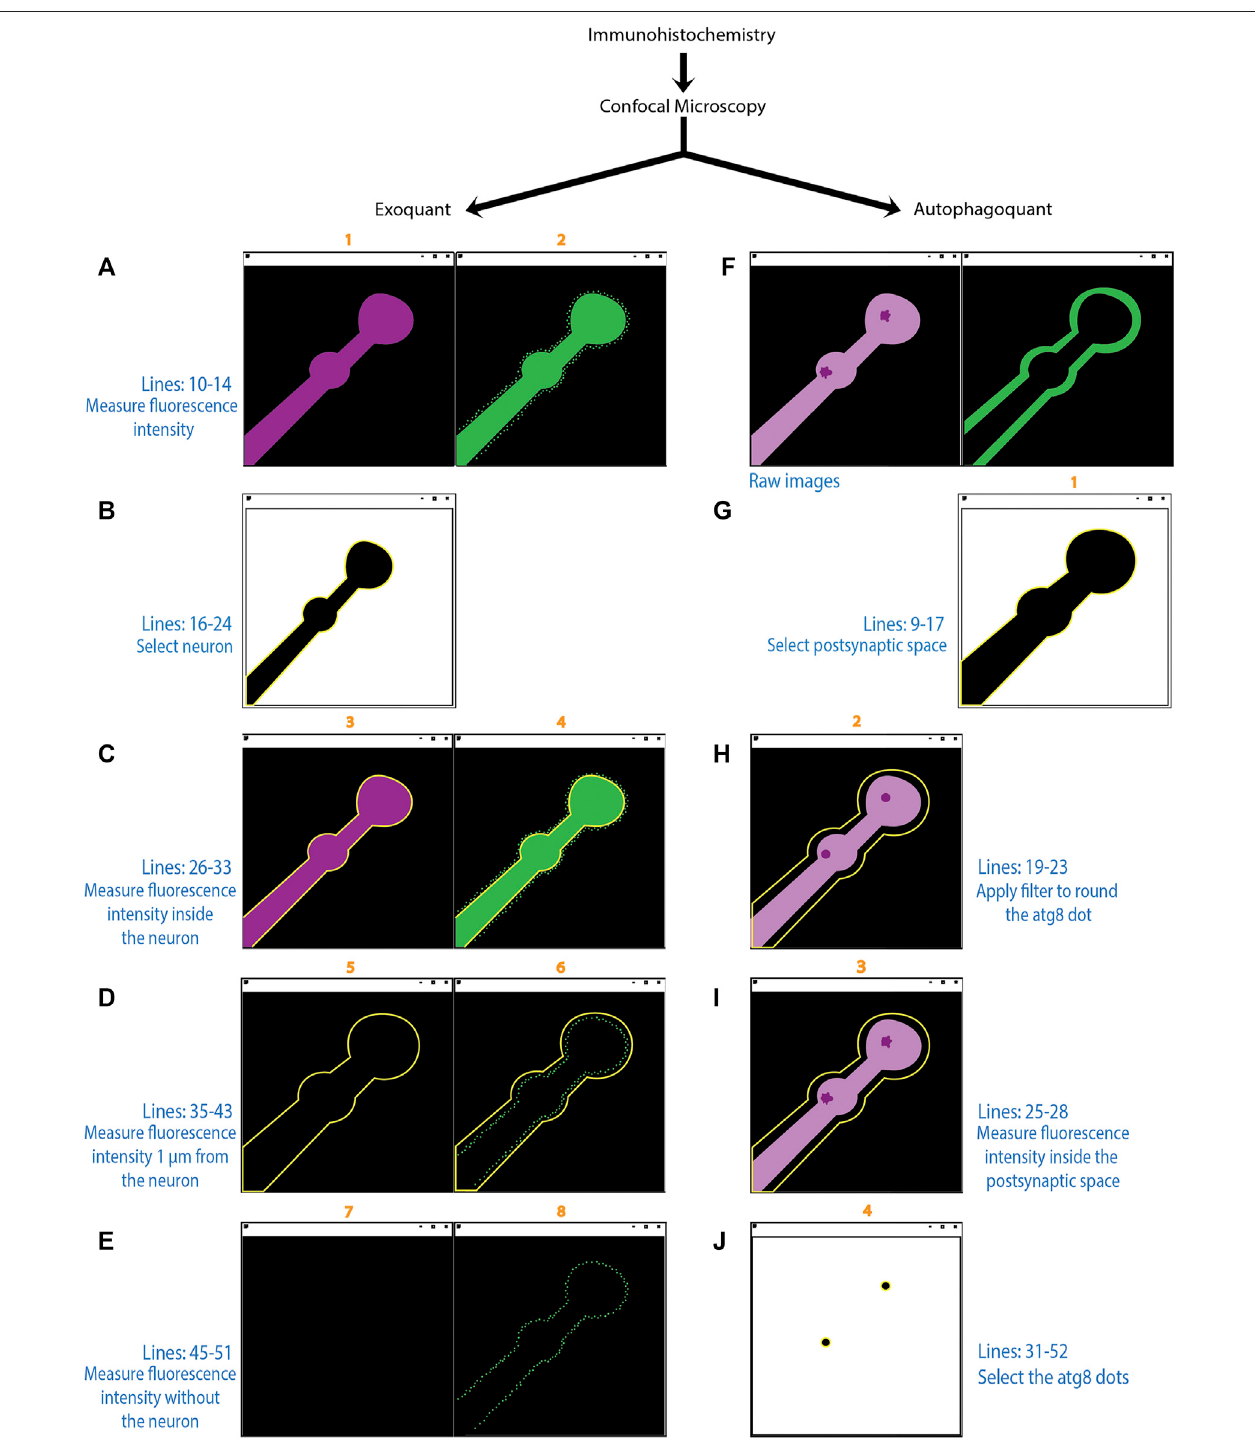
FIGURE 6 | Diagram showing the work fl ow of Exoquant and Autophagoquant macros. Schematic representation showing the function of the two macros in the experimental design. The numbers over the individual pictures (in orange) corresponds to the line in the result window. The precise lines of the code (in blue) and a brief description of the underlying algorithm is described for each step of the macros (Exoquant: A-E; Autophagoquant: F-J). The “ Exoquant ” work fl ow shows the two channelsfrom theoriginalimage obtained intheconfocal microscope, inmagentathe membrane marker(HRP) and ingreenthe protein channel (A) .Fluorescence intensity is measured and stored in lines 1 and 2 of the results table. The membrane channel was thresholded with the Otsu method and highlighted in yellow after the selection with the wand tool (B) . The next step shows the shape of the membrane in both raw images (C) . Fluorescence is measured inside on both channels and